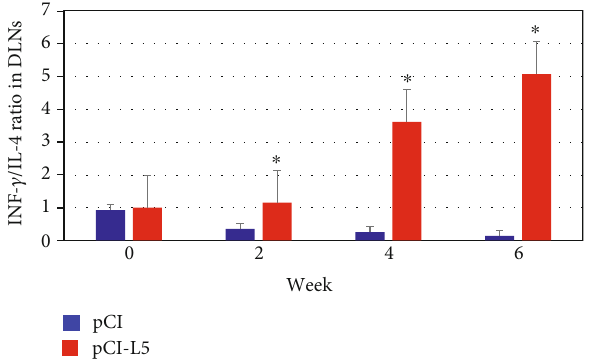
Figure 8: IFN- γ /IL-4 ratio in draining lymph nodes (DLNs) obtained from BALB/c mice inoculated with 100 μ g pCI-L5 vaccine before and after challenge with L. tropica . The IFN- γ /IL-4 ratio in response to pCI-L5 and pCI is compared ( ∗ P < 0 : 05